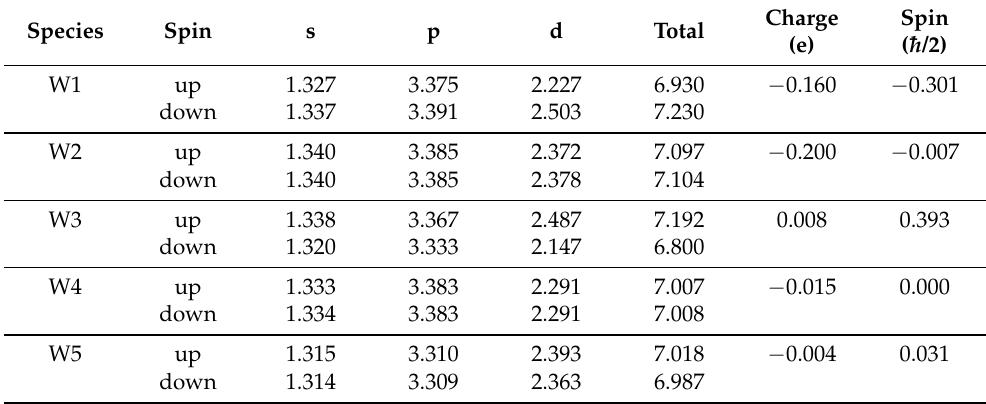
Table A5. Atomic populations (Mulliken) for mq As 2 S 3 :W.